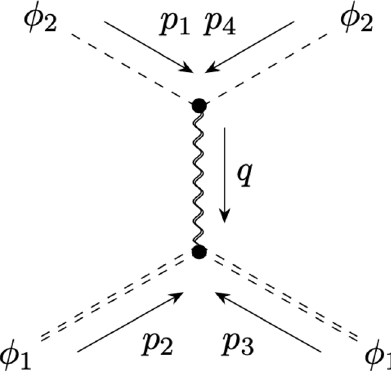
Figure 2 . Feynman’s diagram of gravitational elastic scattering φ 1 ( p 1 ) φ 2 ( p 2 ) → φ 1 ( p 3 ) φ 2 ( p 4 ) , where φ 1 , 2 are two scalar fields (dashed lines), the curly line represent the propagator of the graviton field and p 1 , 2 , 3 , 4 are the four-momenta of in and out states